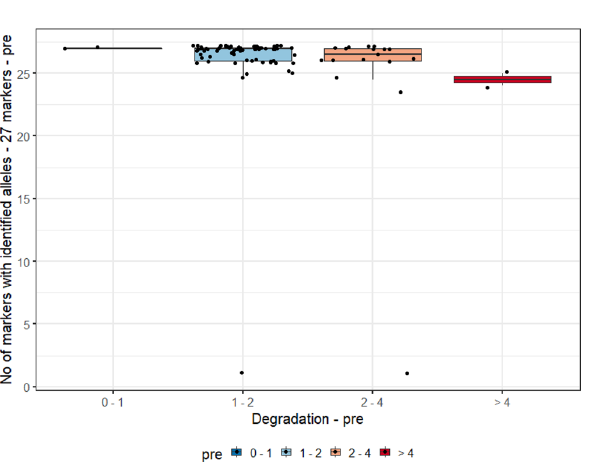
Graph 4. Boxplots of the degradation index range and genetic profile of PowerPlex Fusion 6C System of pre- vasectomy samples (n = 90 individuals).